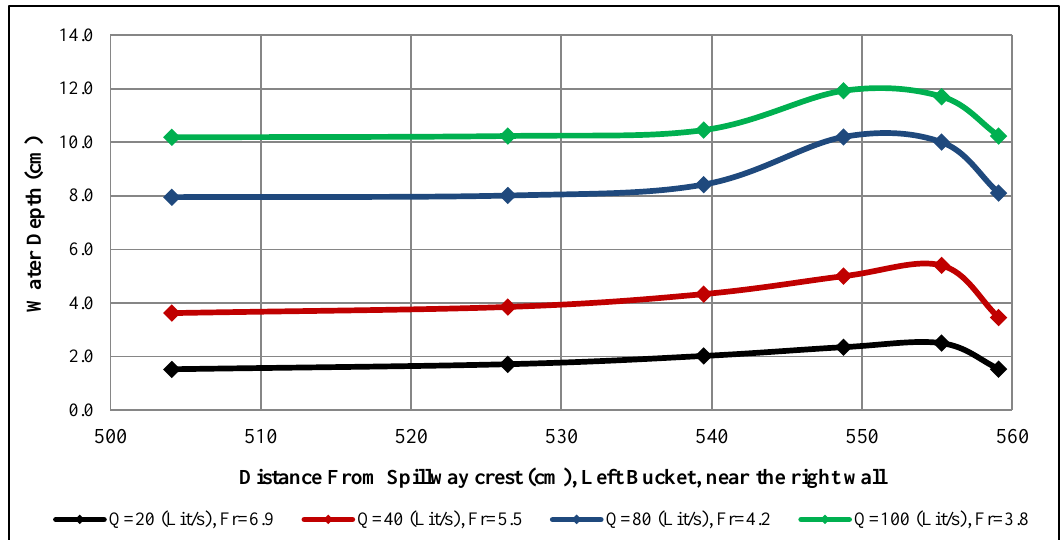
Figure 6. Variation of dynamic pressure on the right bucket along the Centreline